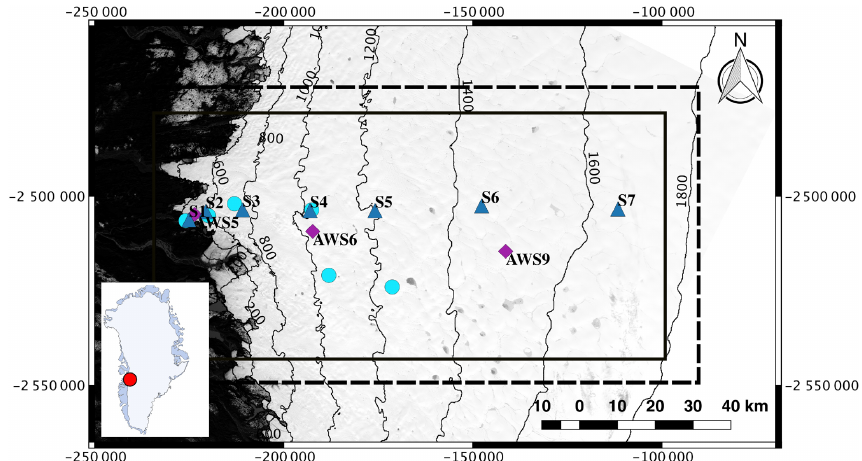
Figure 1. Landsat 8 satellite image acquired on 19 August 2013, band 2, showing the Russell Glacier area. Black solid rectangle outlines the study domain for the integrated model, while the black dashed rectangle outlines the SRLF study domain. The blue triangles show the locations of GPS stations (Tedstone and Neinow, 2017). Purple diamonds show the locations of automatic weather stations (van de Wal et al., 2015). Cyan circles show the locations of moulins used as tracer injections sites in Chandler et al. (2013). Inset shows the location in reference to Greenland.